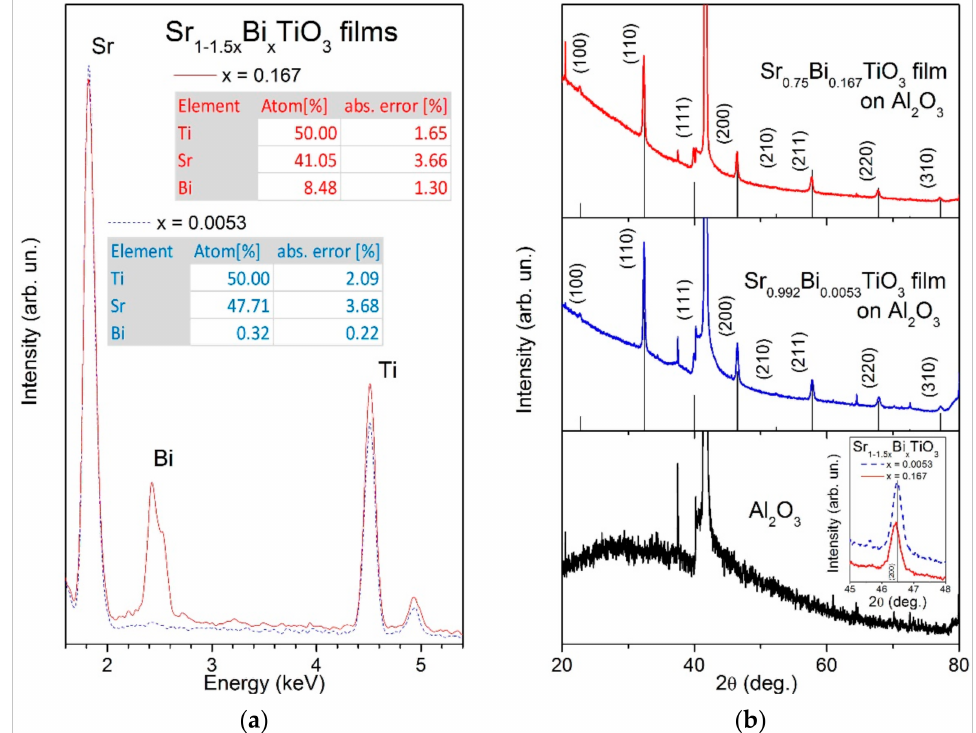
Figure 2. Energy-dispersive spectra and their elemental quantification results ( a ) as well as X-ray diffraction profiles ( b ) for Sr 1 − 1.5x Bi x TiO 3 thin films with x = 0.0053 and 0.167 deposited on Al 2 O 3 substrates. The X-ray diffraction profile for bare Al 2 O 3 substrate is presented in the bottom panel of ( b ). The reflections related to the perovskite structure of SrTiO 3 (PDF#35-0734) with corresponding indexes are also shown in ( b ), as well as magnified view at reflection (200) as inset in the bottom panel of ( b